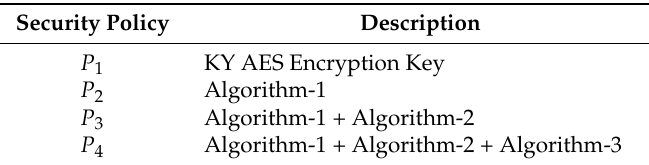
Table 8. Security policy